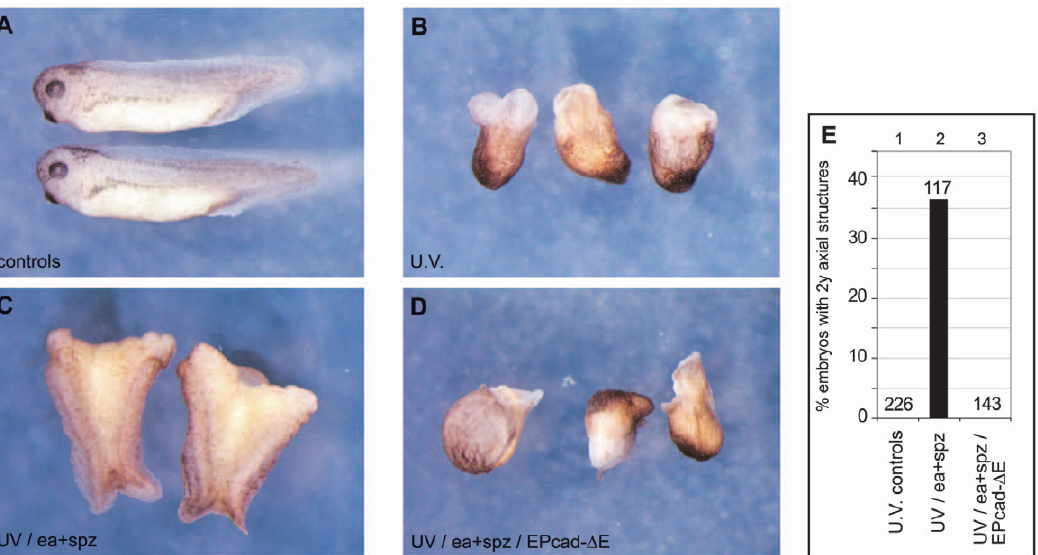
Figure 4. ea/spz-dependent dorsalization requires b -Catenin activity. ( A ) Untreated controls at tadpole stage (NF 35/36). ( B ) UV-ventralized siblings (average DAI=0.30). ( C ) UV-ventralized embryos injected sub-equatorially with 100 pg each of Drosophila easter and spa¨tzle RNA produced embryos with 2 rudimentary trunk axes (37%). ( D ) Embryos injected with 50 pg EPcad D E, in addition to easter and spa¨tzle, did not show any axial rescue (0%). ( E ) Graphical representation of axial rescue, giving total numbers for each experimental cohort.